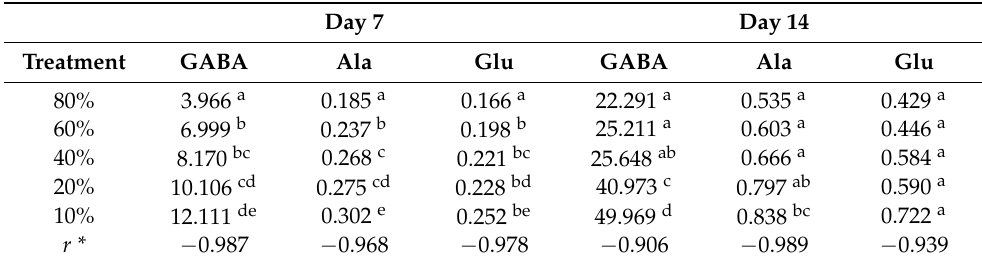
Table 4. Levels of GABA shunt metabolites (GABA, alanine, and glutamate) of pea ( Pisum sativum L.) seedlings in response to soil water holding capacity levels: 80%, 60%, 40%, 20%, and 10% grown under continuous light at 25 ◦ C for 7 days and 14 days, separately. Metabolite levels were calculated as nmol/mgFW. GABA ( γ -Aminobutyric acid), Ala (alanine), Glu (glutamate). Means followed by different letters are significantly different ( p ≤ 0.05) by LSD; r = correlation